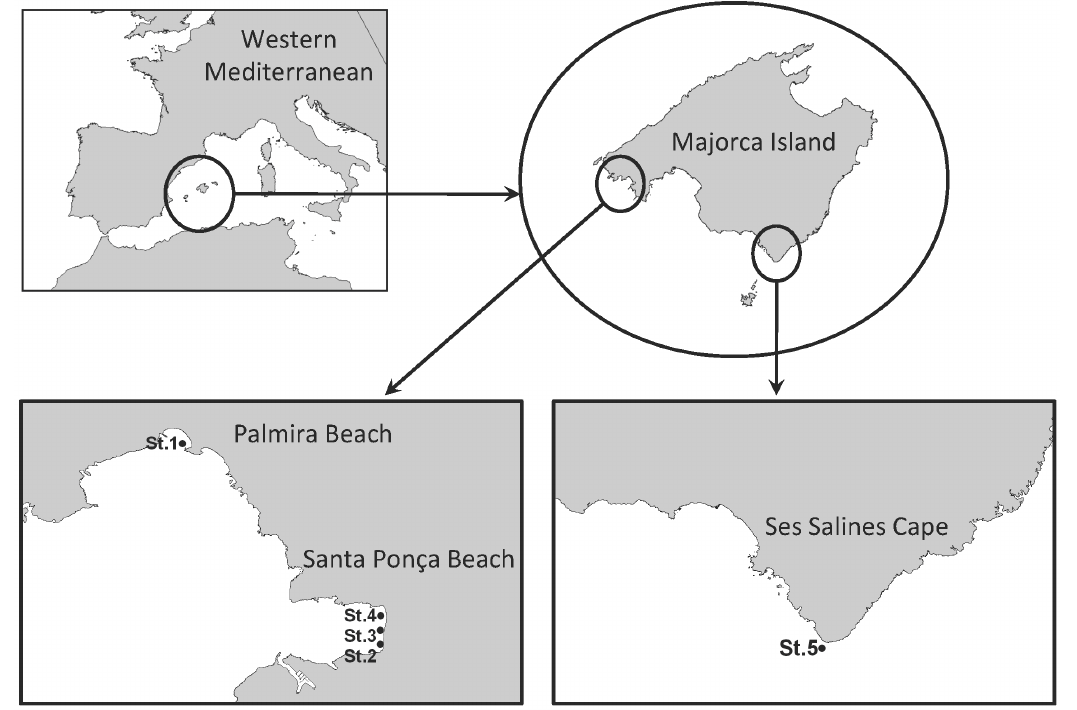
Figure 1. Sampling locations: St.1 (Palmira Beach); St.2, St.3, St.4 (Santa Ponc¸a beach); St.5 (Ses Salines Cape).